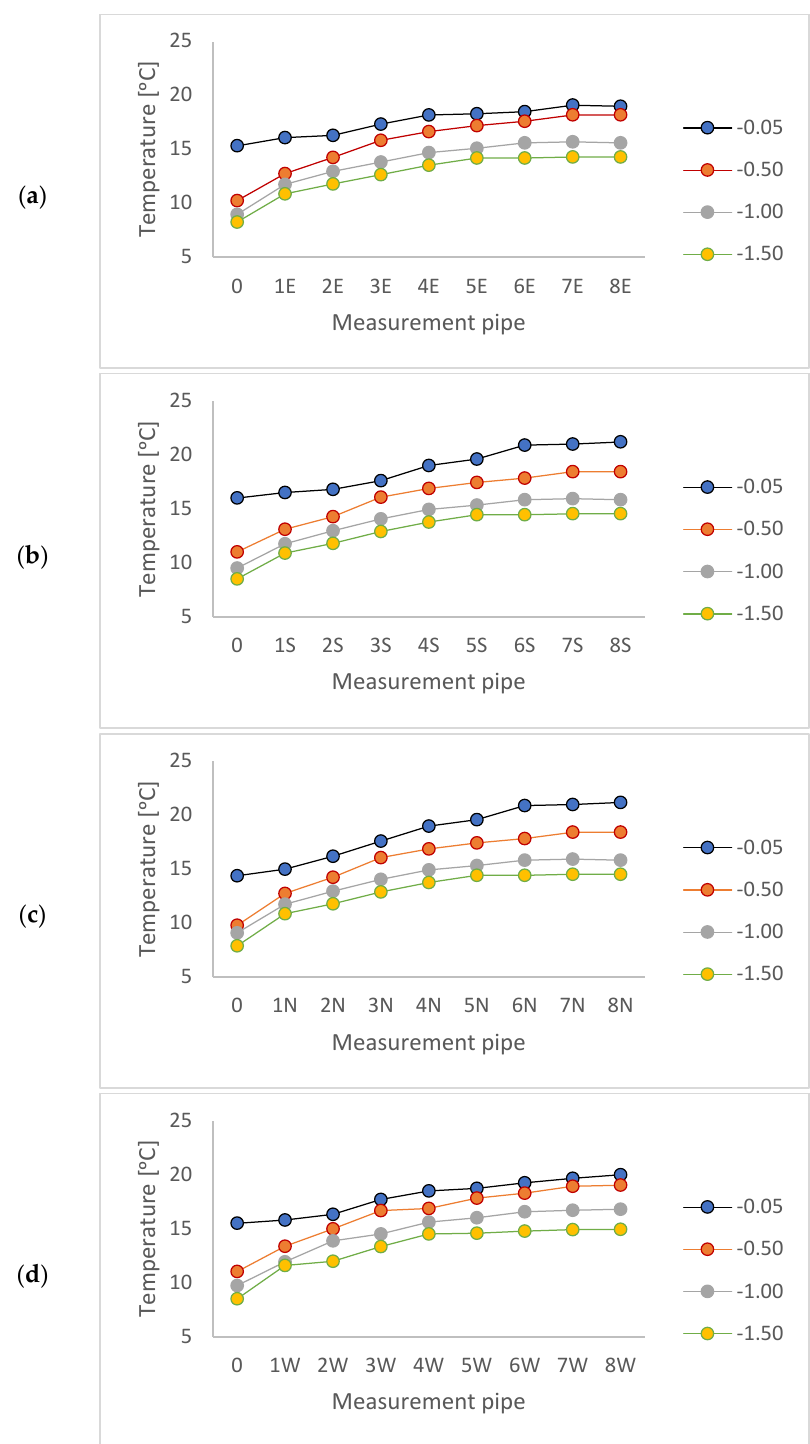
Figure 8. Ground temperature in the studied measurement columns at depths of 0.05 m, 0.50 m, 1.00 m, and 1.50 m to the: ( a ) east, ( b ) south, ( c ) north, and ( d ) west. Summer period (June 25, Θ e = 27.7 °C; Θ i = 4.0 °C).